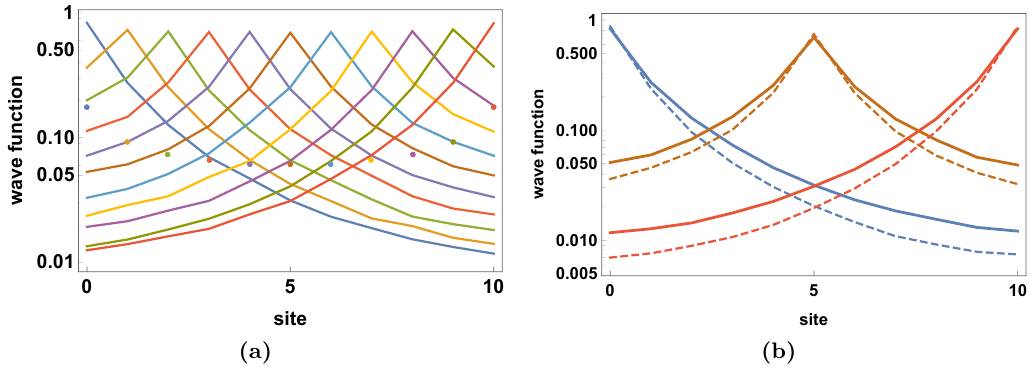
Figure 3. (a) The averaged zero mode wave functions for a random CW with N = 10 with uniform priors for k and m . We separately average over the wave functions that peak at a given site. The dots mark the probabilities for the peaks to occur at that site, given in eq. (3.6). (b) Some of the same wave functions for uniform (solid) and Gaussian (dashed)